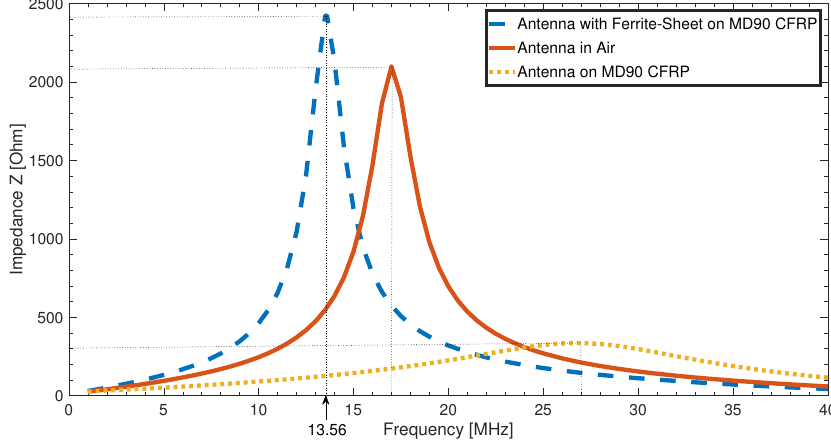
Figure 9. Impedance measurements of tag in air (red, solid), on CFRP (yellow, dotted), and combined with ferrite sheet and CFRP (blue,